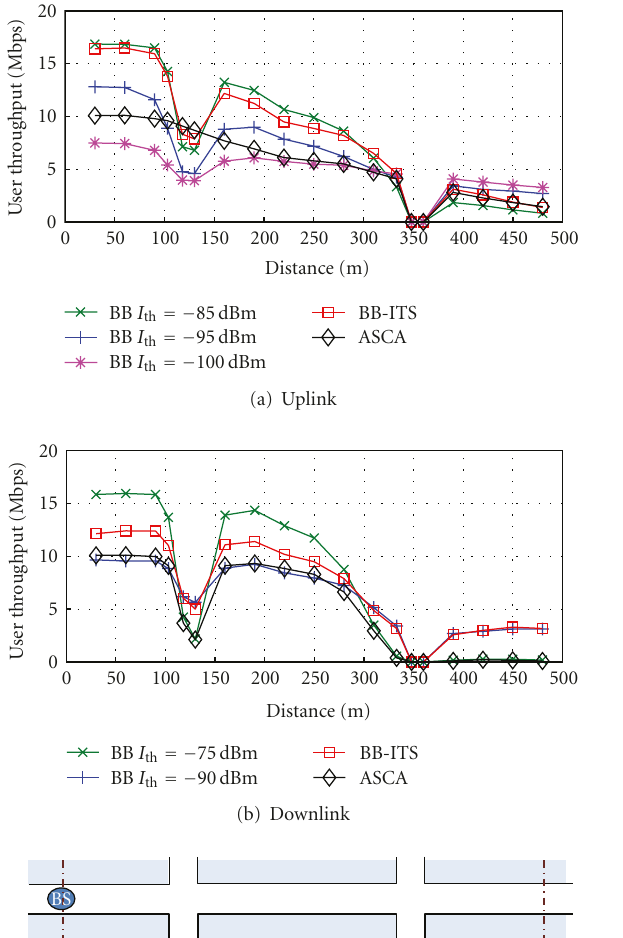
Figure 8: Cumulative distributive function (cdf) of Jain’s fairness index (12) for BB-OFDMA compared to full-frequency reuse with- out interference avoidance (ASCA) both with 16-QAM